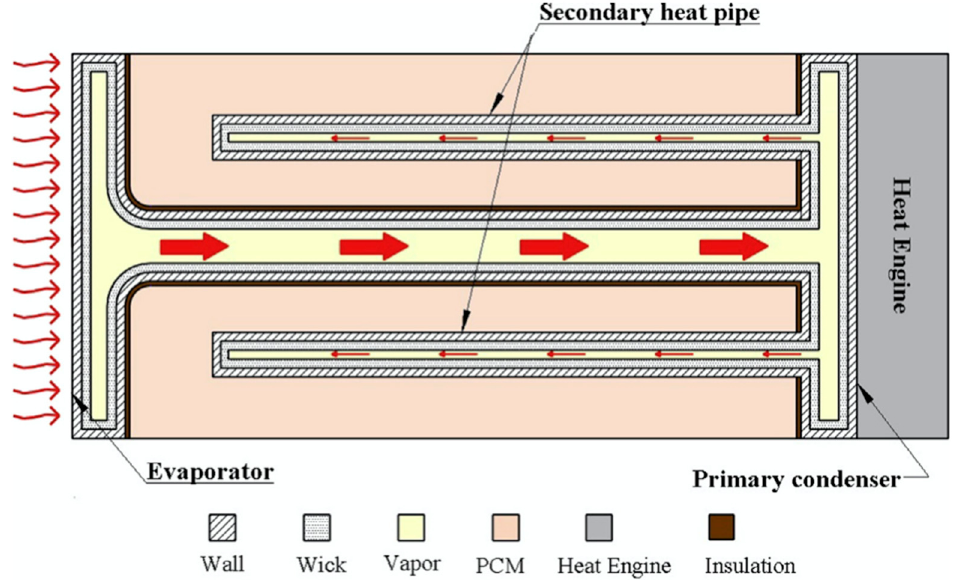
Figure 3. Heat pipe network schematic from Mahdavi et al. (Copyright 2016 Elsevier) [13].